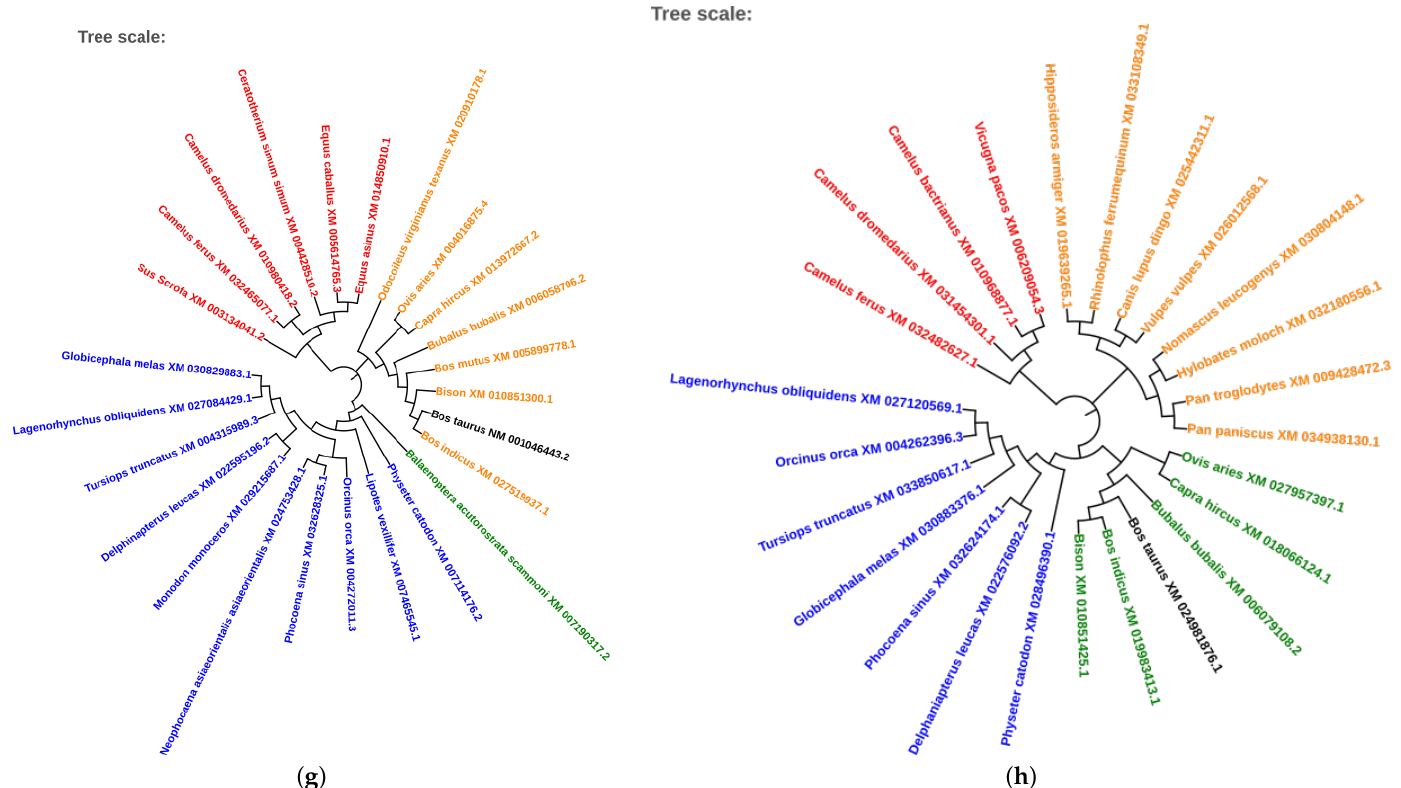
Figure 7. Phylogenetic tree representing the evolutionary conservation of transcription factors. Bos taurus is illustrated in black, and the nodes are color coded in four di ff erent groups, with red and orange representing the two di ff erent sub clades from the first divergence, and blue and green representing the other two sub clades. ( a ) Transcription factor AREB6; ( b ) ARNT; ( c ) C-Rel; ( d ) CREB; ( e ) HLF; ( f ) LMO2; ( g ) NKX2-5; ( h )